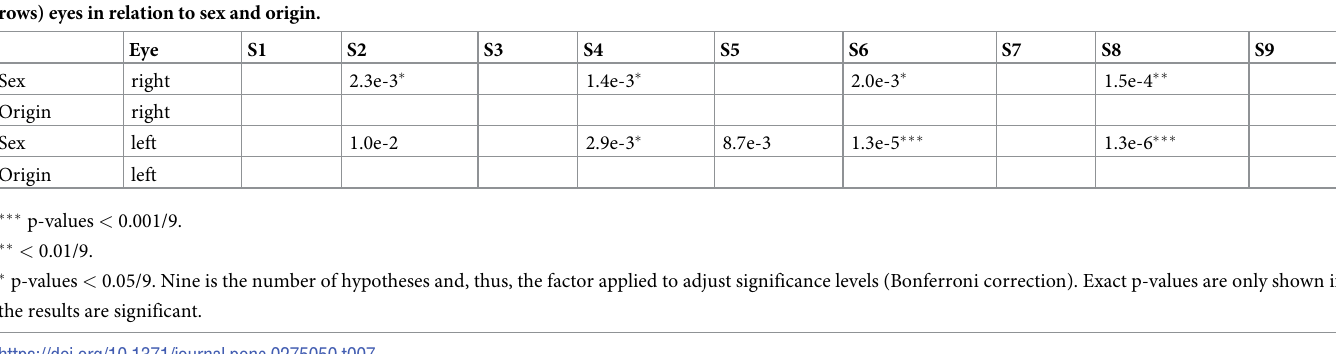
S1 Table. The results for volume choroid data with regard to sex, origin, and eye side were included.